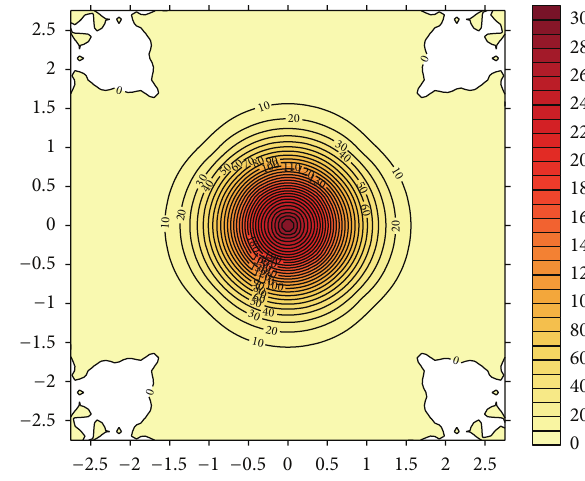
Figure 17: 300 ∘ C thermal contours.